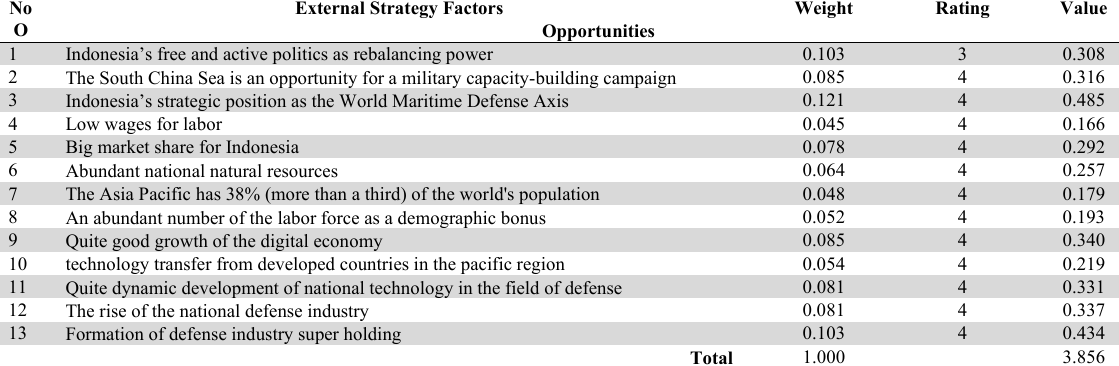
Scores and Weights for External Factors in Opportunity